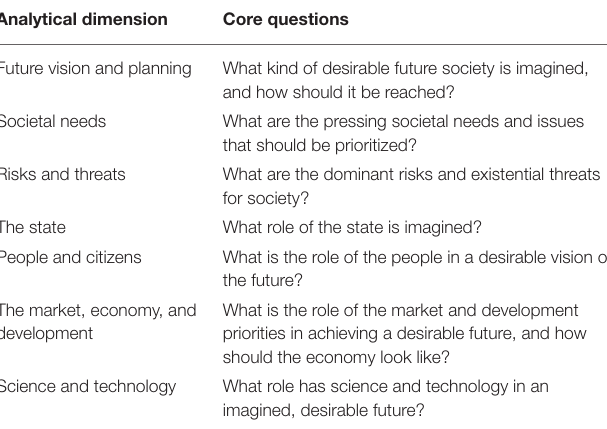
TABLE 1 | Analytical dimensions and guiding questions related to sociotechnical imaginaries. Analytical